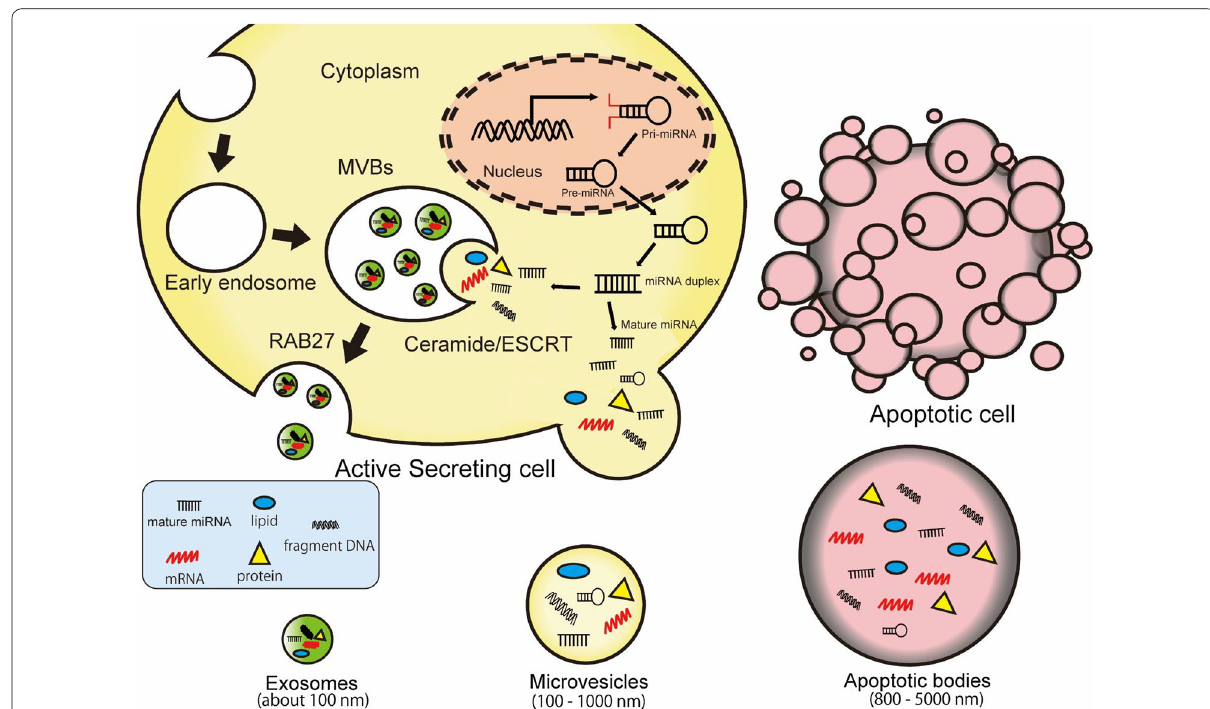
Fig. 1 The classification of extracellular vesicles. EVs contain various molecules, such as miRNAs, mRNAs, DNAs, proteins and lipids. Exosomes are formed by inward budding into early endosomes to form MVBs. This inward budding process involves ceramide-dependent mechanisms or an ESCRT. Subsequently, these MVBs fuse with the limiting plasma membrane to release exosomes into the extracellular space. This fusion process is dependent on Rab GTPases (e.g., Rab27A/B). MVs are directly shed or bud from the plasma membrane. Apoptotic bodies are released from the cell undergoing programmed cell death. Pri-miRNA: primary